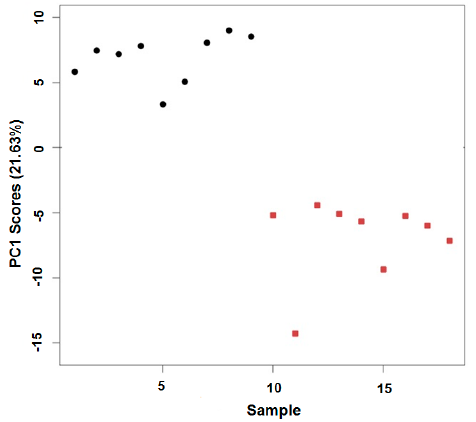
Figure 3. PCA (principal component analysis) scores plot showing sample identity vs. principal component 1 (PC1) score from the in vitro air oxidation of D. magna lipid extracts. Control samples (1–9) are denoted by black circles ( ); exposed samples (10–18) are denoted by red squares ( (cid:4) ). Data are presented in this format as no separation of groups was visible in the higher order PCs.